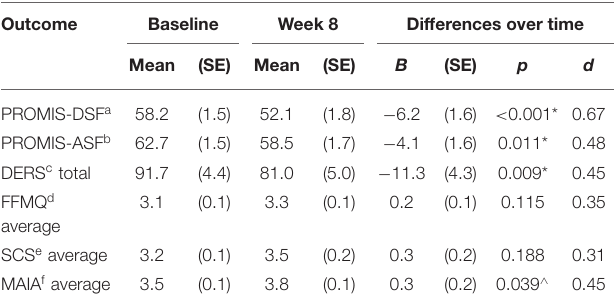
TABLE 5 | Mixed-effects analysis.